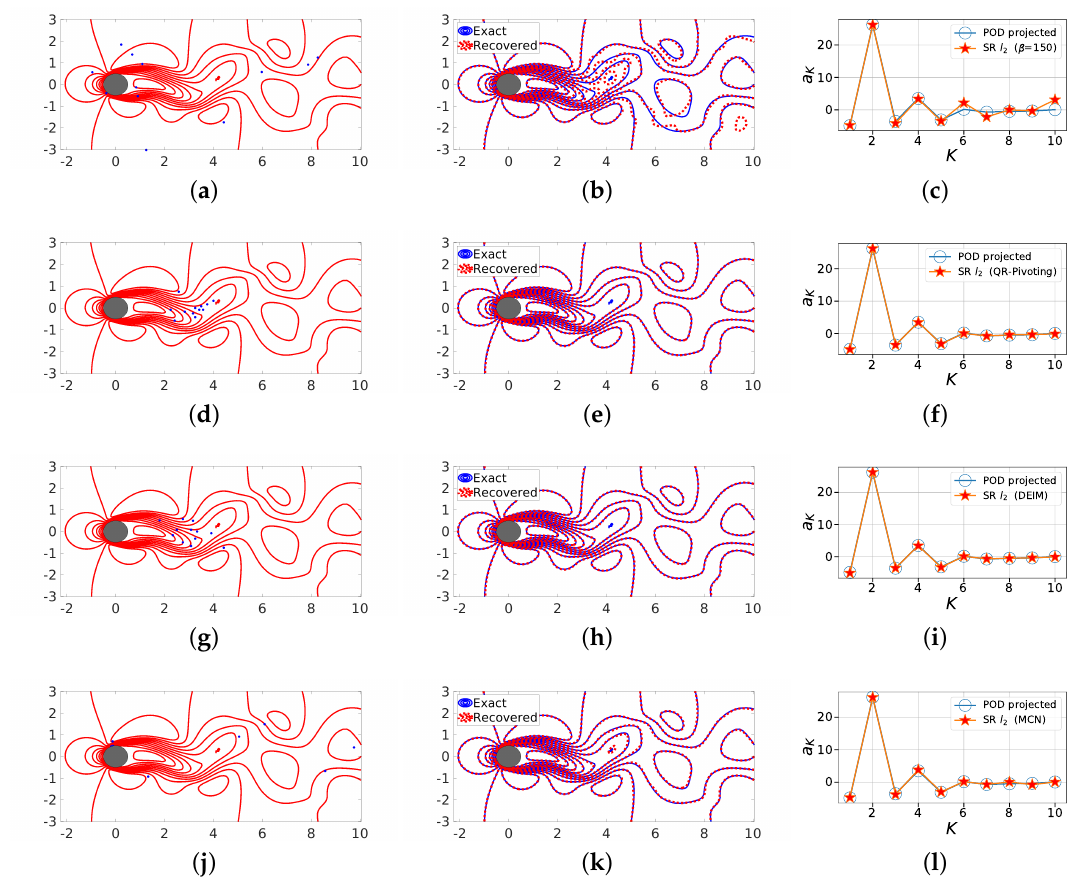
Figure 15. Dissection of instantaneous snapshot reconstruction for a marginally oversampled case ( K ∗ = 5, P ∗ = 6) . The figure shows the different sensor locations, namely random sensors with seed β = 150 ( a ), QR factorization with column pivoting ( b ), DEIM ( c ) and minimum condition number (MCN) ( d ) along with the corresponding overlaid true and reconstructed solutions ( b , e , h , k ), and the recovered coefficients a ( c , f , i , l ) using POD-based SR for Re = 100. The corresponding error quantifications for the different cases are as follows. First row: (cid:101) 1 = 2.46 × 10 − 1 and (cid:101) 2 = 8.18. Second row: (cid:101) 1 = 5.20 × 10 − 2 and (cid:101) 2 = 2.37. Third row: (cid:101) 1 = 4.44 × 10 − 2 and (cid:101) 2 = 1.47. Fourth row: (cid:101) 1